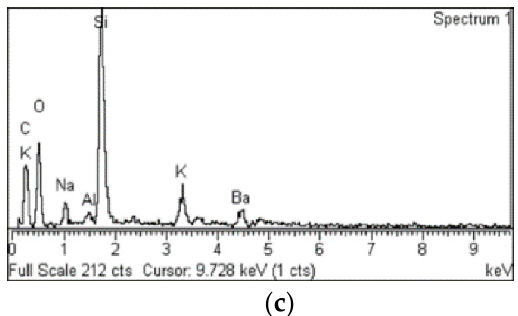
Figure 1. ESEM and X-EDS characterization of RGA: ( a ) micrograph of coarse RGA, ( b ) micrograph of fine RGA, ( c ) X-EDS microanalysis.